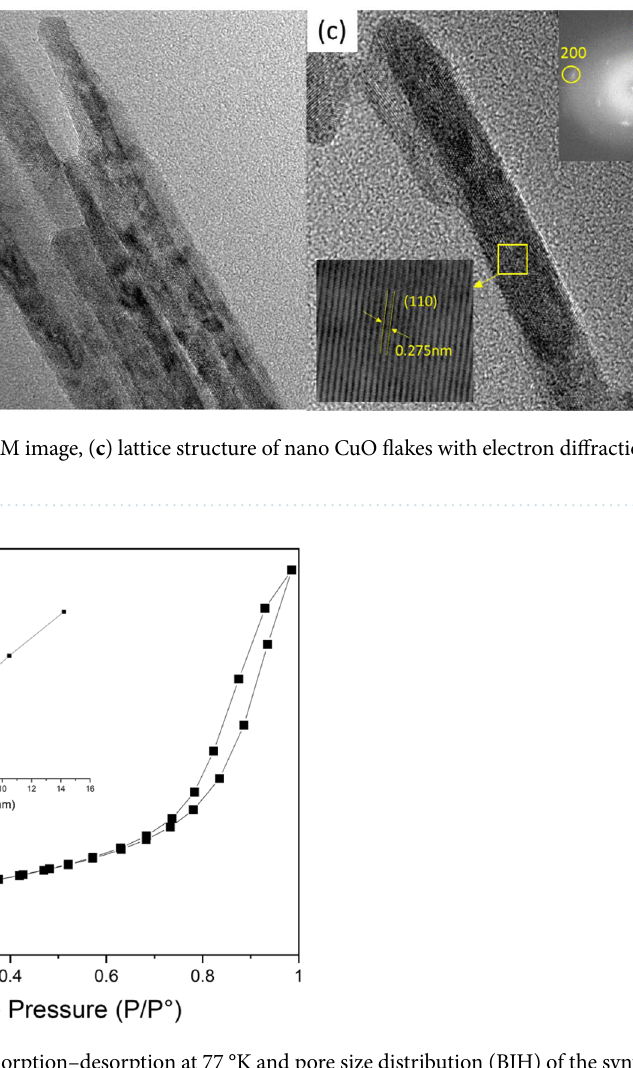
Figure 4. Isotherms for N 2 adsorption–desorption at 77 °K and pore size distribution (BJH) of the synthesised nano